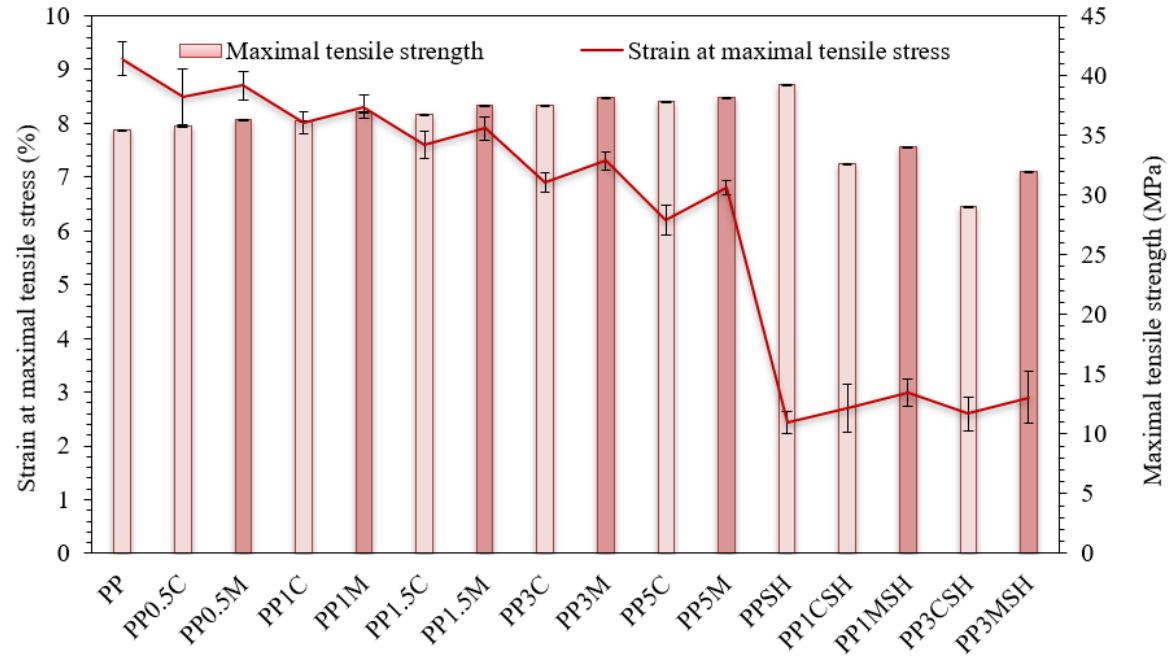
Figure 10. Strain at maximal tensile stress and maximal tensile strength of PP-modified composites and neat PP; darker bars are related to the masterbatch-containing systems.